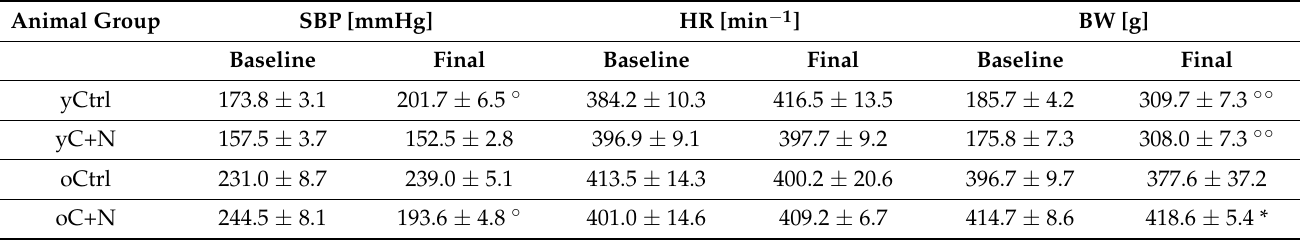
Table 1. SBP, HR, and BW of young and old